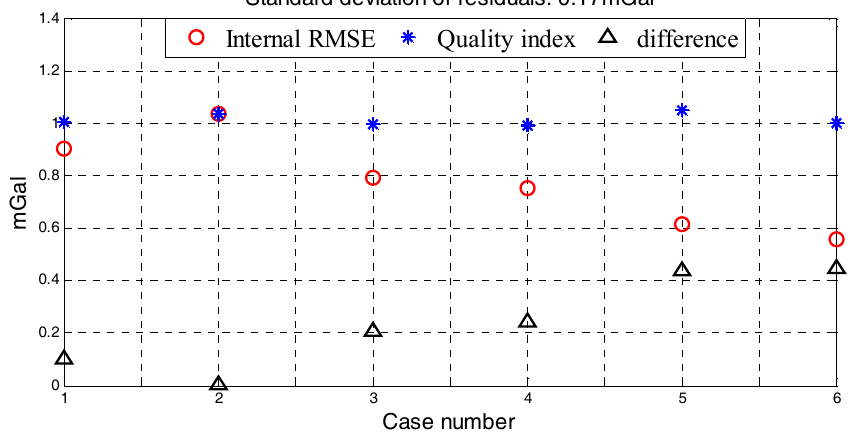
Figure 16. Different between internal RMSE and Quality assessment results in Neimeng flight.